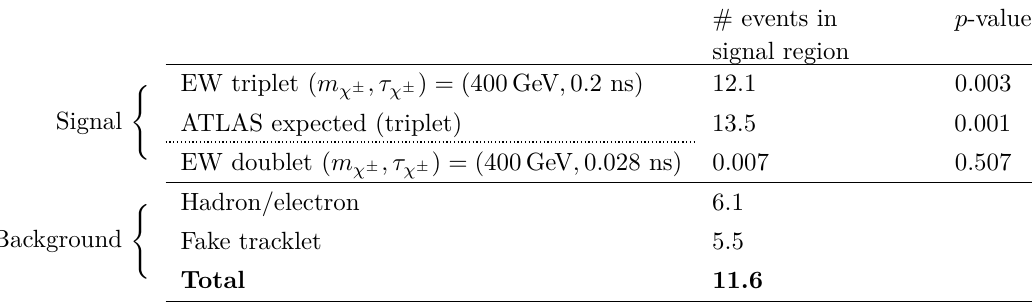
Table 4 . The number of expected events for signal benchmarks and for backgrounds with the tracklet p T > 100 GeV in the signal region. The ATLAS analysis does not list a signal number for the EW doublet. As discussed in sections 2.4.1 and 2.4.2, the background normalization and p T distributions are identical to those in the ATLAS analysis by construction. The p -value in the last column is calculated by integrating the probability distribution function for the number of events in the presence of signal past the median value in the absence of